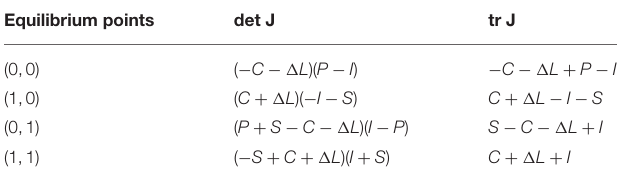
TABLE 3 | The results of det J and tr J for the dynamic system II. Equilibrium points det J tr J